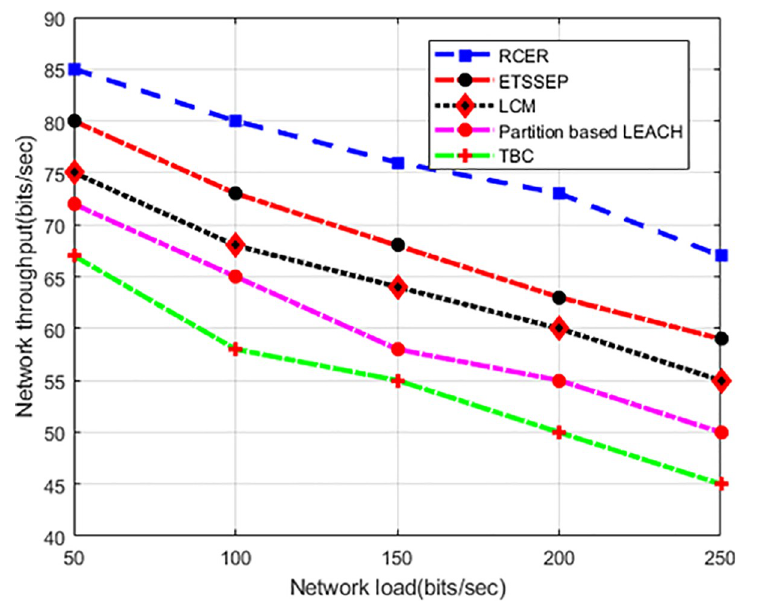
Fig 13. Network throughput in varying network